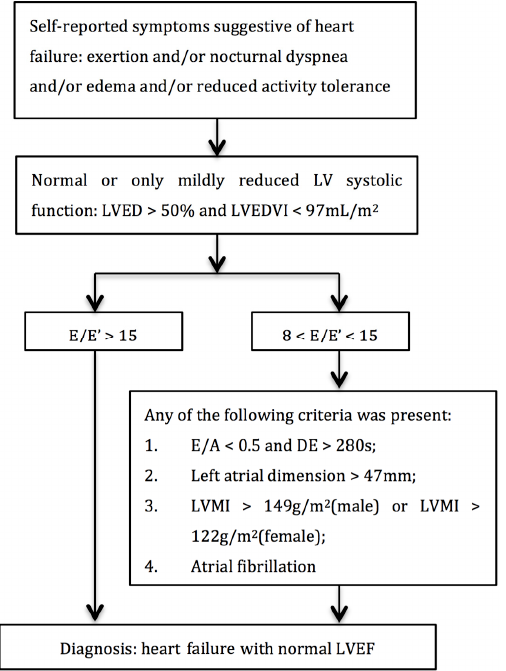
Figure 1. Diagnostic flowchart of heart failure with preserved ejection fraction (HFpEF). A: atrial diastolic filling wave velocity; E: early diastolic filling wave velocity; E’: early diastolic mitral annular velocity; LV: left ventricle; DE: E wave deceleration time; LVED: left ventricular end diastolic diameter; LVEDVI: left ventricular enddiastolic volume index; LVEF: left ventricular ejection fraction; LVMI: left ventricular mass index.